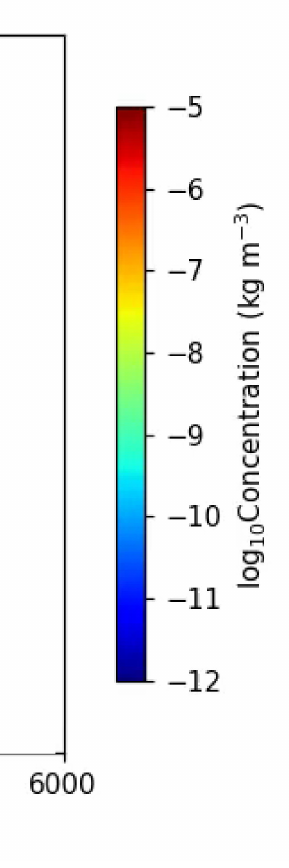
Figure 3. Variability in the dispersion patterns. Five sample realizations of near-surface concentration, 10 min after the start of the tracer release, were generated by varying the release start time or release location in the time-varying turbulent environment produced by the GPU-LES